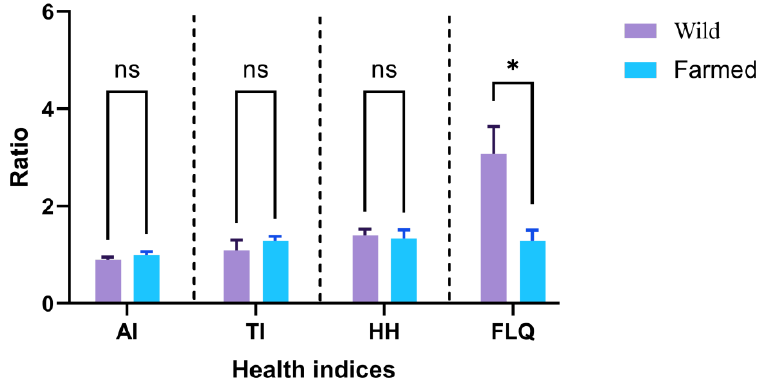
Figure 3. Variations in lipid quality indices of atherogenicity index (AI); thrombogenicity index (TI); hypocholesterolemic: hypercholesterolemic (HH); and flesh lipid quality (FLQ) ratio of the muscles in wild and farmed pangasius. Data were subjected to multiple unpaired t -test and significant level set at p < 0.05. Asterisk (*) indicates highly significant difference and ns, non-significant.